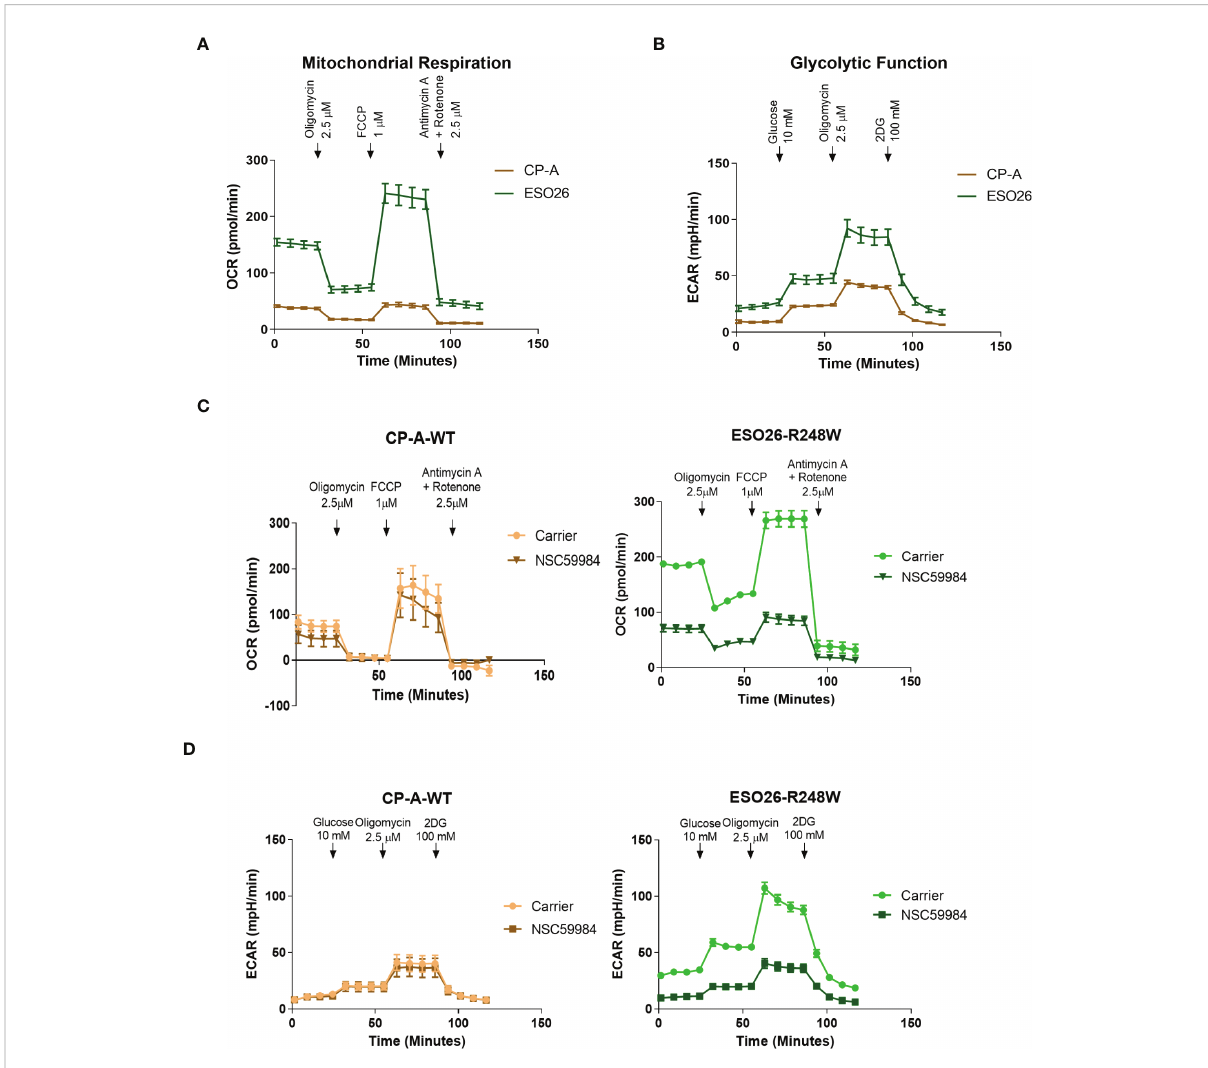
FIGURE 2 GOF mutant p53 alters cellular metabolic pro fi les. (A) Basal mitochondrial respiration, as measured with the Seahorse XF e 96 Cell Mito Stress Test Kit, in the panel of EAC cells. Arrows indicate addition of metabolism-modulating drugs. (B) Basal glycolytic function, as measured with the Seahorse XF e 96 Glycolytic Stress Test Kit, in the panel of EAC cells. Arrows indicate addition of metabolism-modulating drugs. (C) Mitochondrial function was measured using the Seahorse XF e 96 Cell Mito Stress Test Kit following treatment with NSC59984 (12 m M) for 72 hr in EAC cells. (D) Glycolytic function was measured using the Seahorse XF e 96 Glycolytic Stress Test Kit following treatment with NSC59984 (12 m M) for 72 hr in EAC cells. * = 0.05, ** = 0.005, *** = 0.0005, **** =